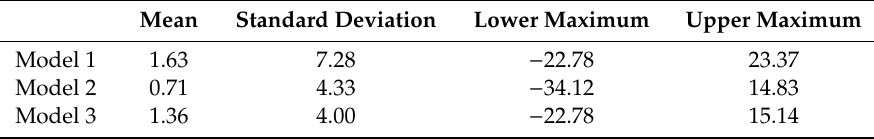
Figure 10. Distribution of errors in the proposed models: ( a ) box plot of error distribution in the models; ( b ) histogram of error distribution in Model 1; ( c ) histogram of error distribution in Model 2; ( d ) histogram of error distribution in Model 3. Table 6. Residual by model after correcting the camera movement error (mm).